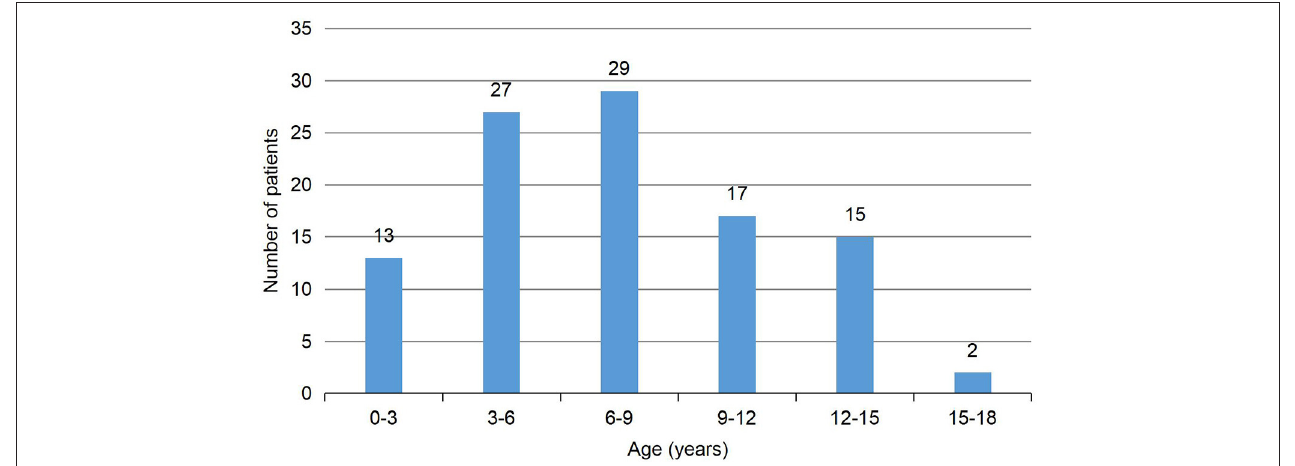
FIGURE 2 | Distribution of age of patients with autoimmune encephalitis.